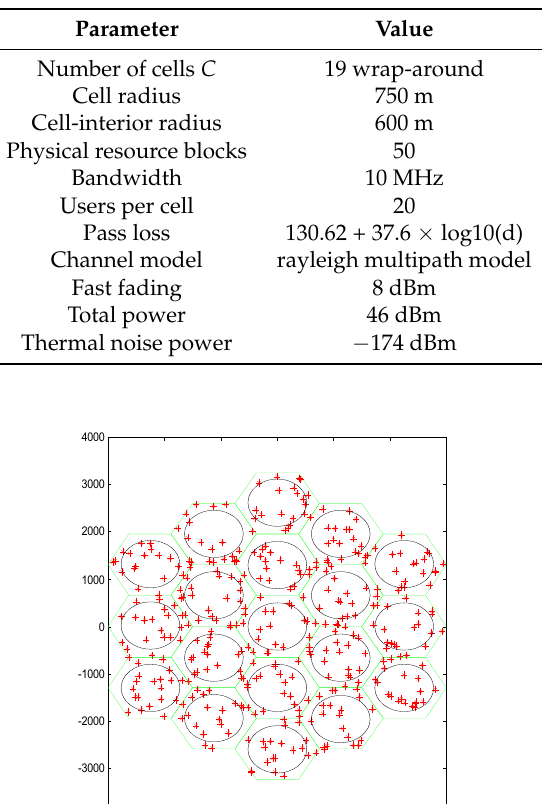
Table 2. Main simulation parameters.